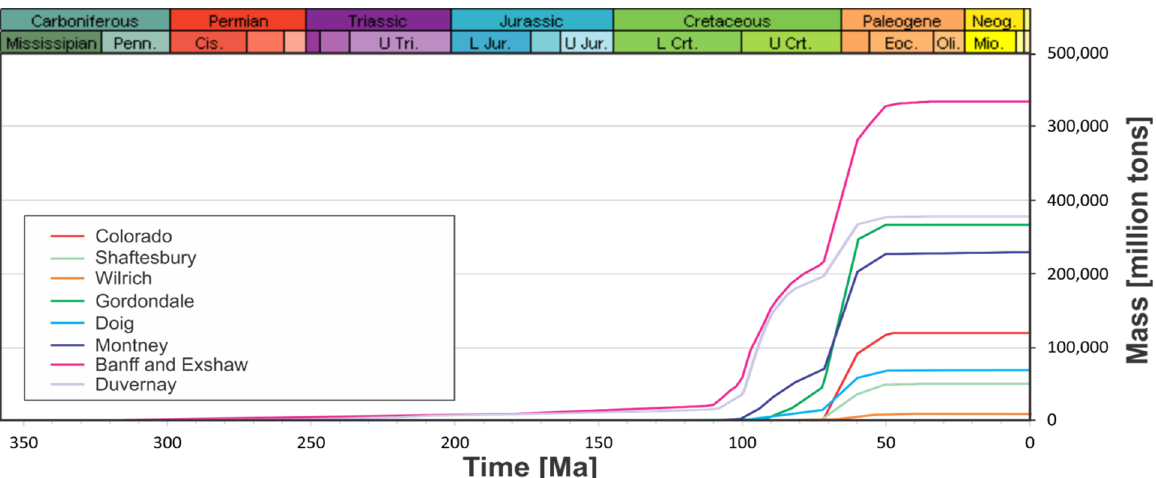
Figure 18. Petroleum generation of the source rocks simulated in the basin model, showing the onset and plateauing of generation. The Colorado Group provided the largest volumes of hydrocarbons, with the Montney Formation producing the fourth largest volumes after the Duvernay and Gordondale formations.